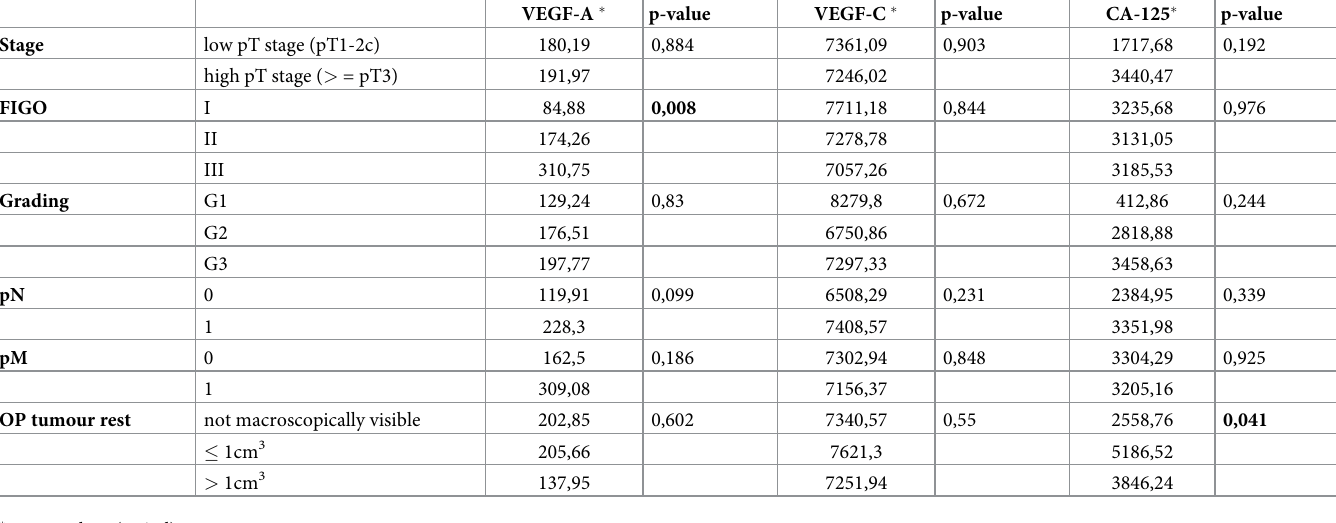
Table 2. Correlation between clinico-pathological parameters and serum VEGF-A, VEGF-C and CA-125 levels in the ovarian cancer cohort. VEGF-A � p-value VEGF-C � p-value CA-125 �